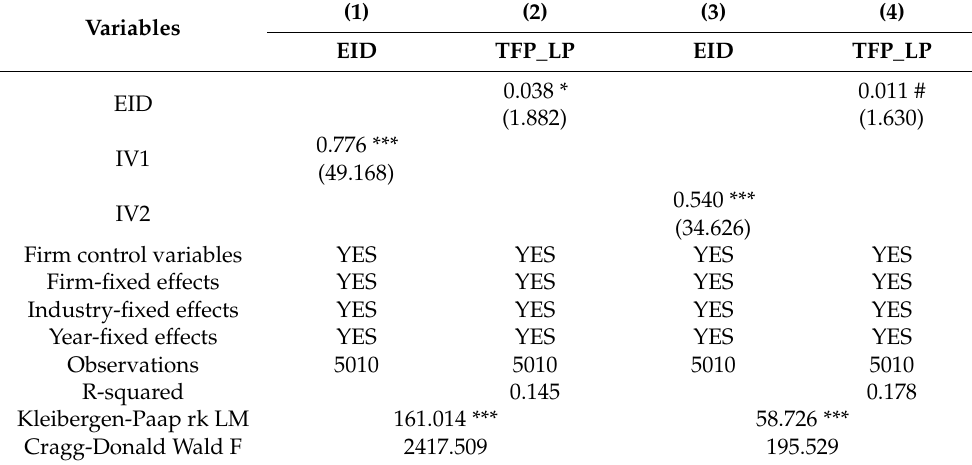
Table 4. Robustness test: instrumental variable